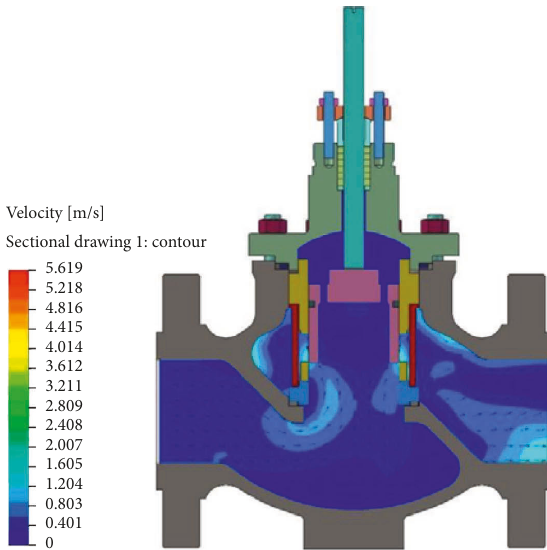
Figure 11: Flow trace diagram for 20% opening.